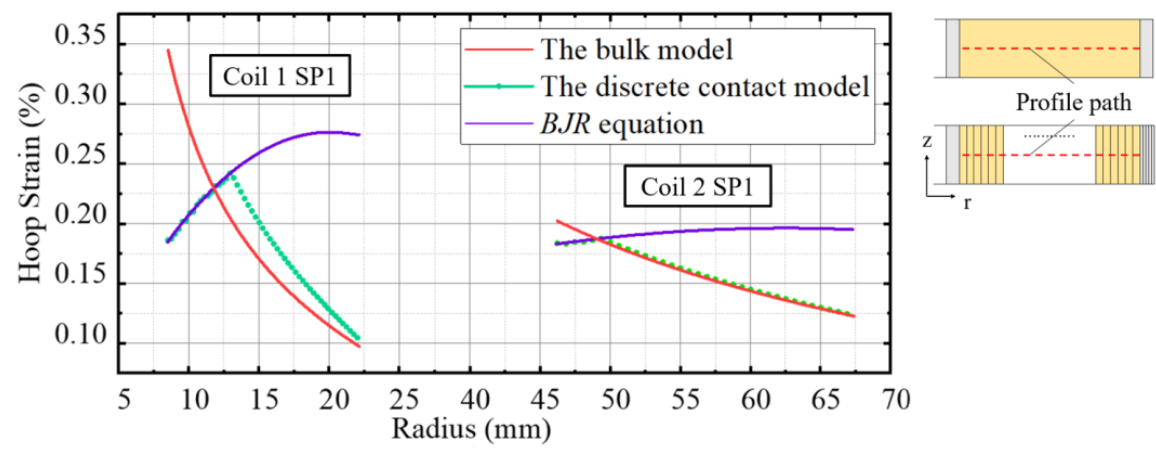
Figure 3. Hoop strain’s distribution on Coil 1&2 SP 1 using two mechanical models and BJR equation. The legend illustrates the corresponding latitude locations of the profile path.